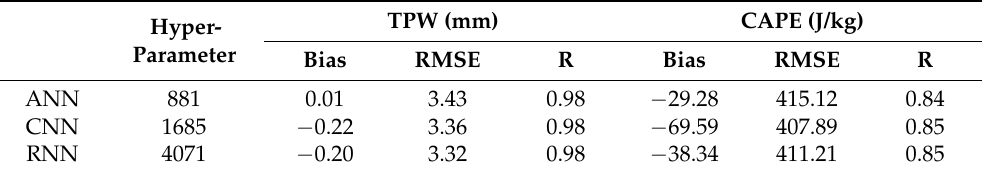
Table A1. Accuracy assessment with ERA5 for ANN, CNN, and RNN model in the ELA region during the test period. Evaluation metrics (i.e., bias, RMSE, and R) are